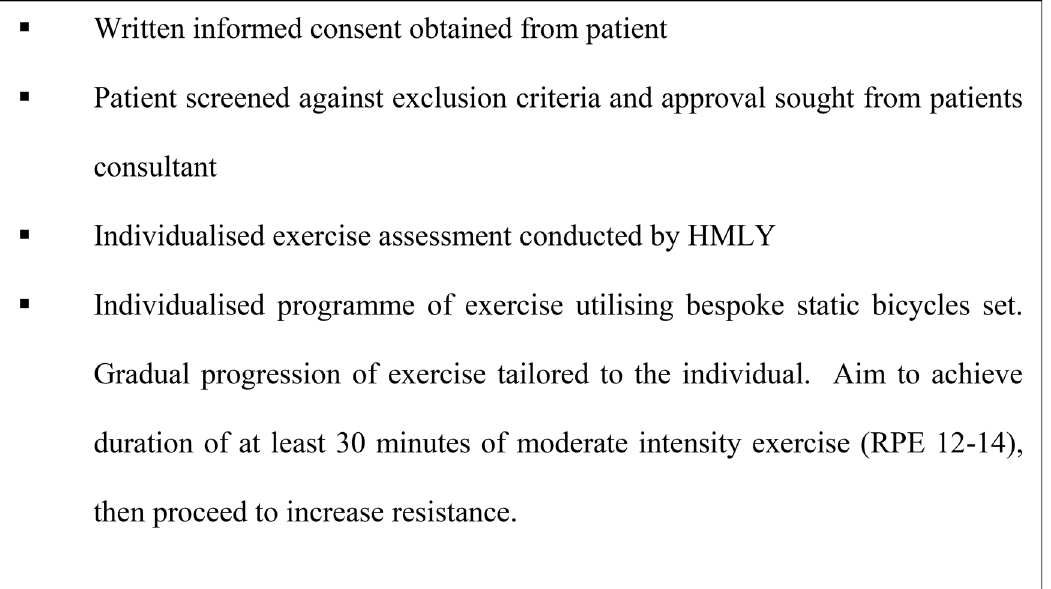
Fig 2. Outline of the IDE programme. An overview of the IDE programme implemented with the satellite unit following phase one of the